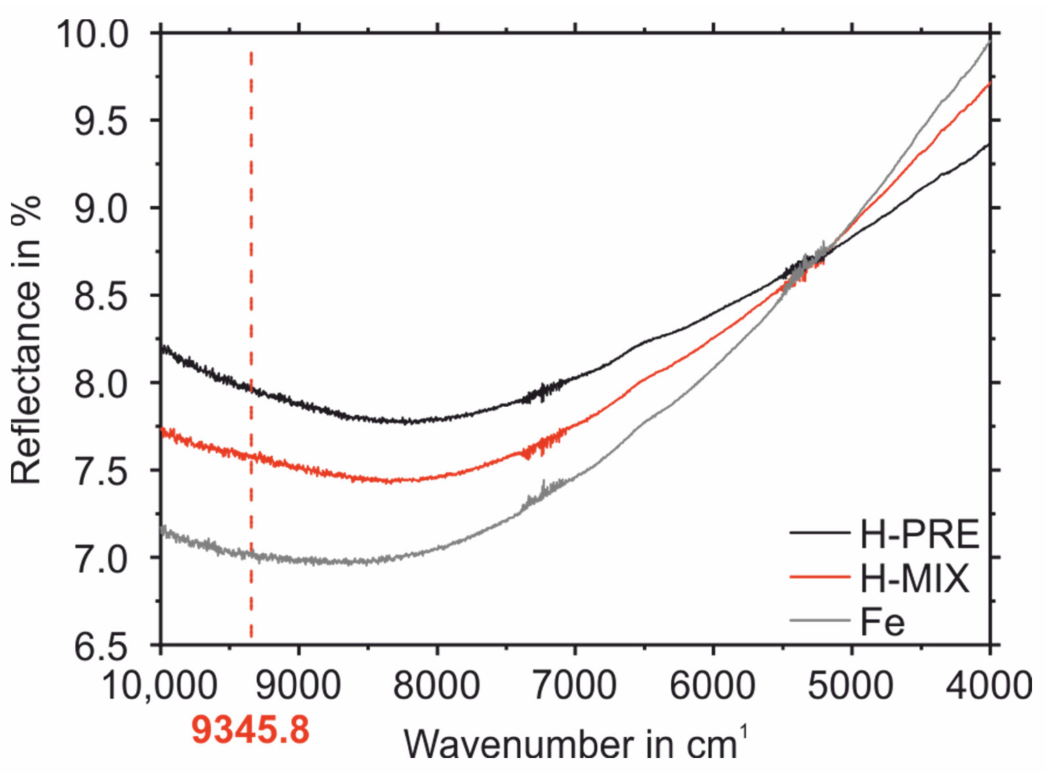
Figure 8. Reflectance spectra of H-PRE, H-MIX, and Fe.